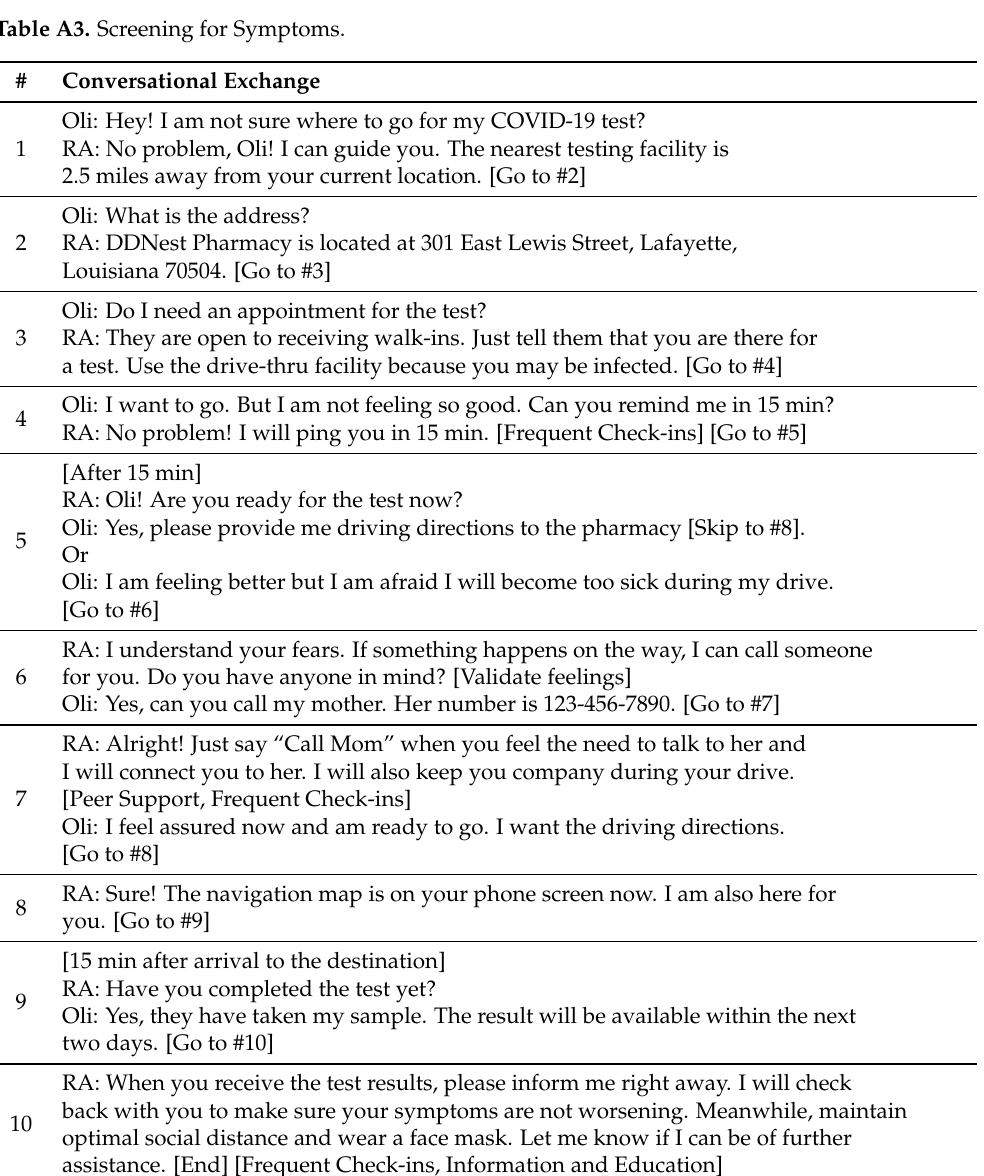
Table A3. Screening for